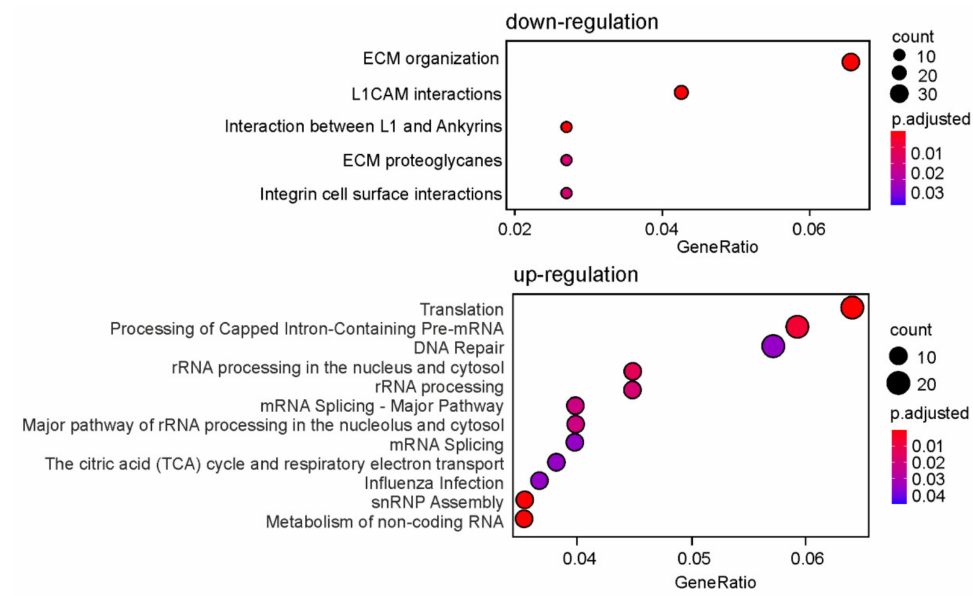
Figure 4. Dotplot enrichment maps showing cellular pathways associated with (t)DEGs whose activity is down-regulated (only the top 5 are shown) or up-regulated (only the top 12 are shown) in HEK293T cells knocked down of uL5. The colors of the points depend on p.adj values, and their sizes are determined by the numbers of (t)DEGs associated with the corresponding pathways in the Gene Ontology terms (color and dot size keys are shown to the right of the